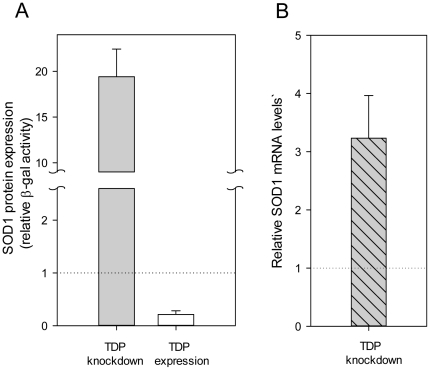
Regulation of SOD1 levels by TDP-43.
A) TDP-43 knockdown or over expression was carried out in HeLa TetOn cells expressing the A4V reporter plasmids. Supernatant fractions were assayed for β-gal activity. Soluble SOD1 reporter expression levels (β-gal activity) relative to controls (dotted line) are shown. Sample sizes ranged from 8 to 23. The error bars represent 95% confidence interval. B) Quantitative PCR analysis of SOD1 reporter mRNA levels was carried out on total mRNA isolated from cells transfected with control or TDP-43 siRNA and A4VSOD1 reporter plasmids. The SOD1 mRNA levels of TDP siRNA treated samples are shown relative to control (dotted line). The error bars represent 95% confidence interval.